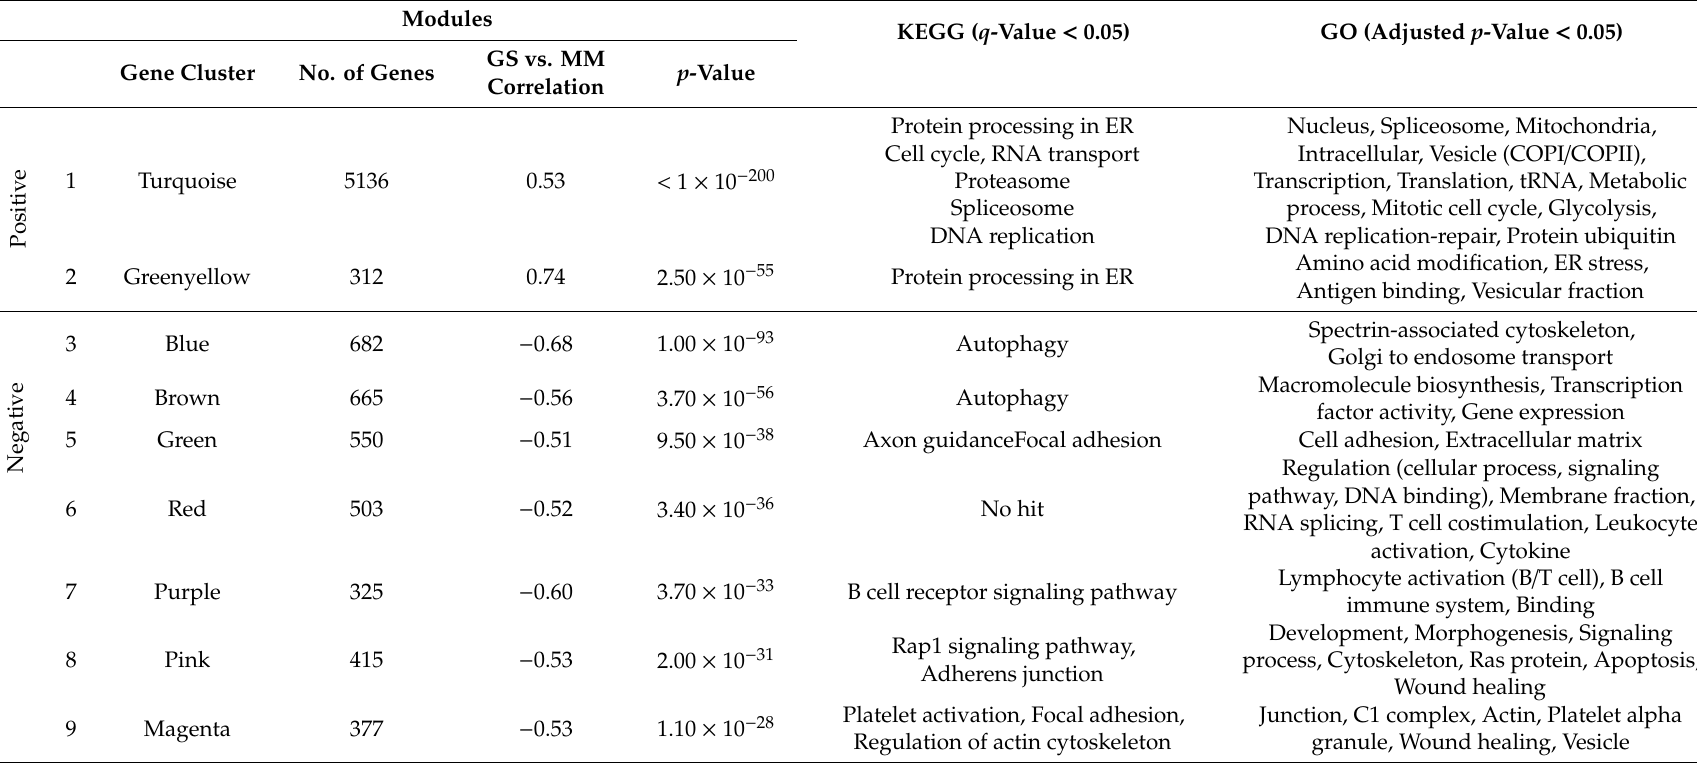
Table 1. Summary of 9 modules (absolute correlation value between gene significance (GS) and module membership (MM) greater than 0.5, and p -value < 0.05) and the most significant enriched KEGG pathways ( q -value < 0.05) and GO terms (adjusted p -value < 0.05) in each